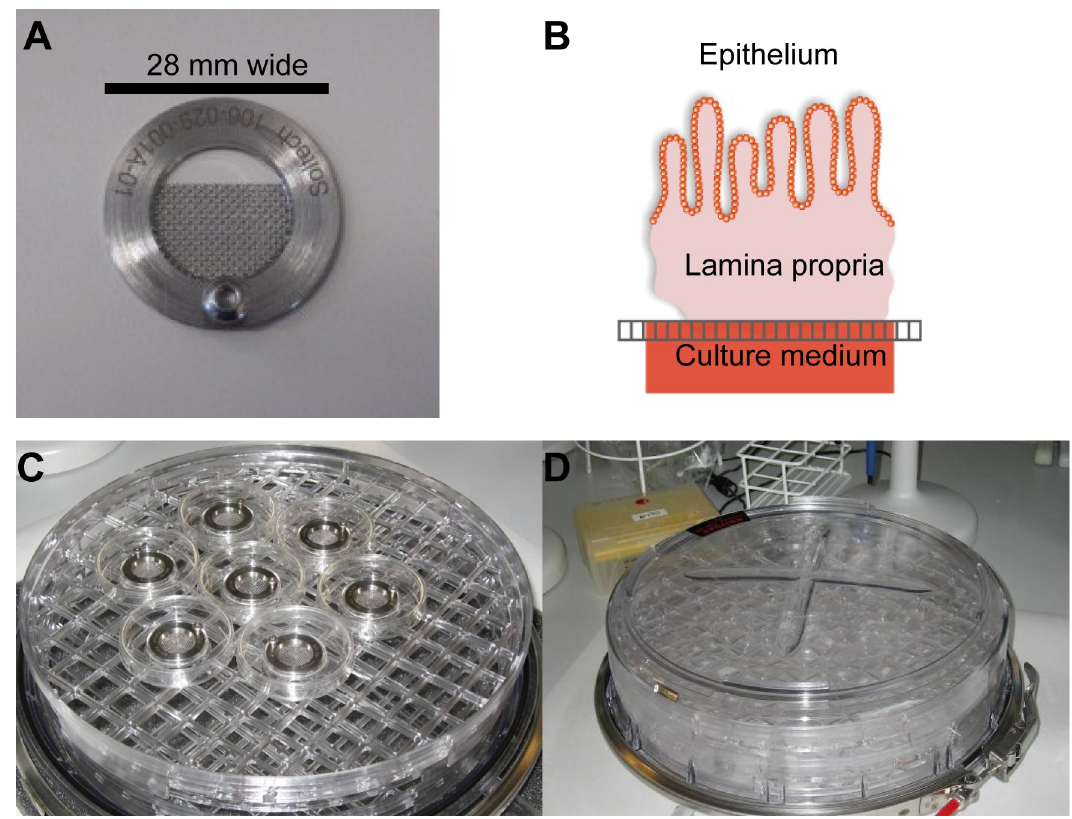
Fig 1. Explant assay setup. (A) Reusable T-disk with a central metal mesh designed to fit into the Falcon center-well organ culture dish. (B) Cartoon of a biopsy placed on the T-disk in air/liquid interphase oriented with the epithelial cell layer upwards and the cut surface downwards, slightly submerged in the medium. (C) Picture of the open incubator. (D) Picture of the sealed